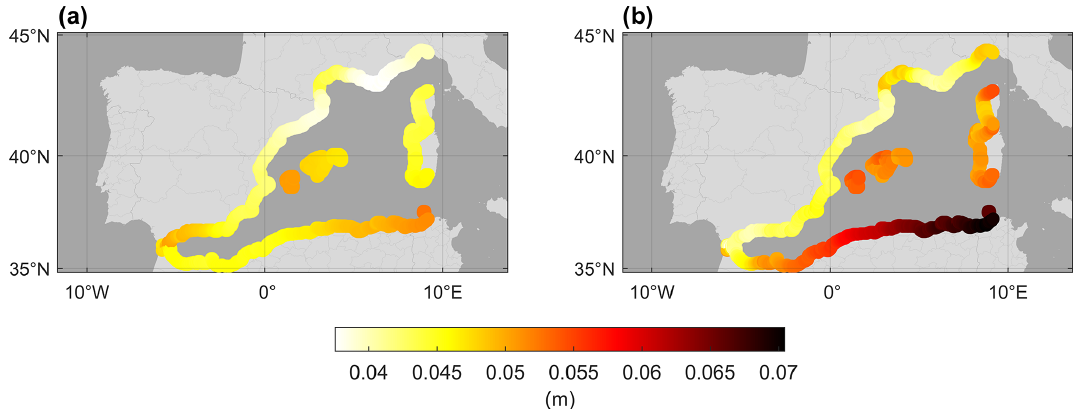
Figure 8. (a) Average interpolation error for the monthly merging of the reconstructions. (b) Average interpolation error for the daily merging of the